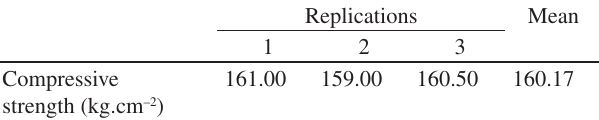
Table 7. Results of confirmation